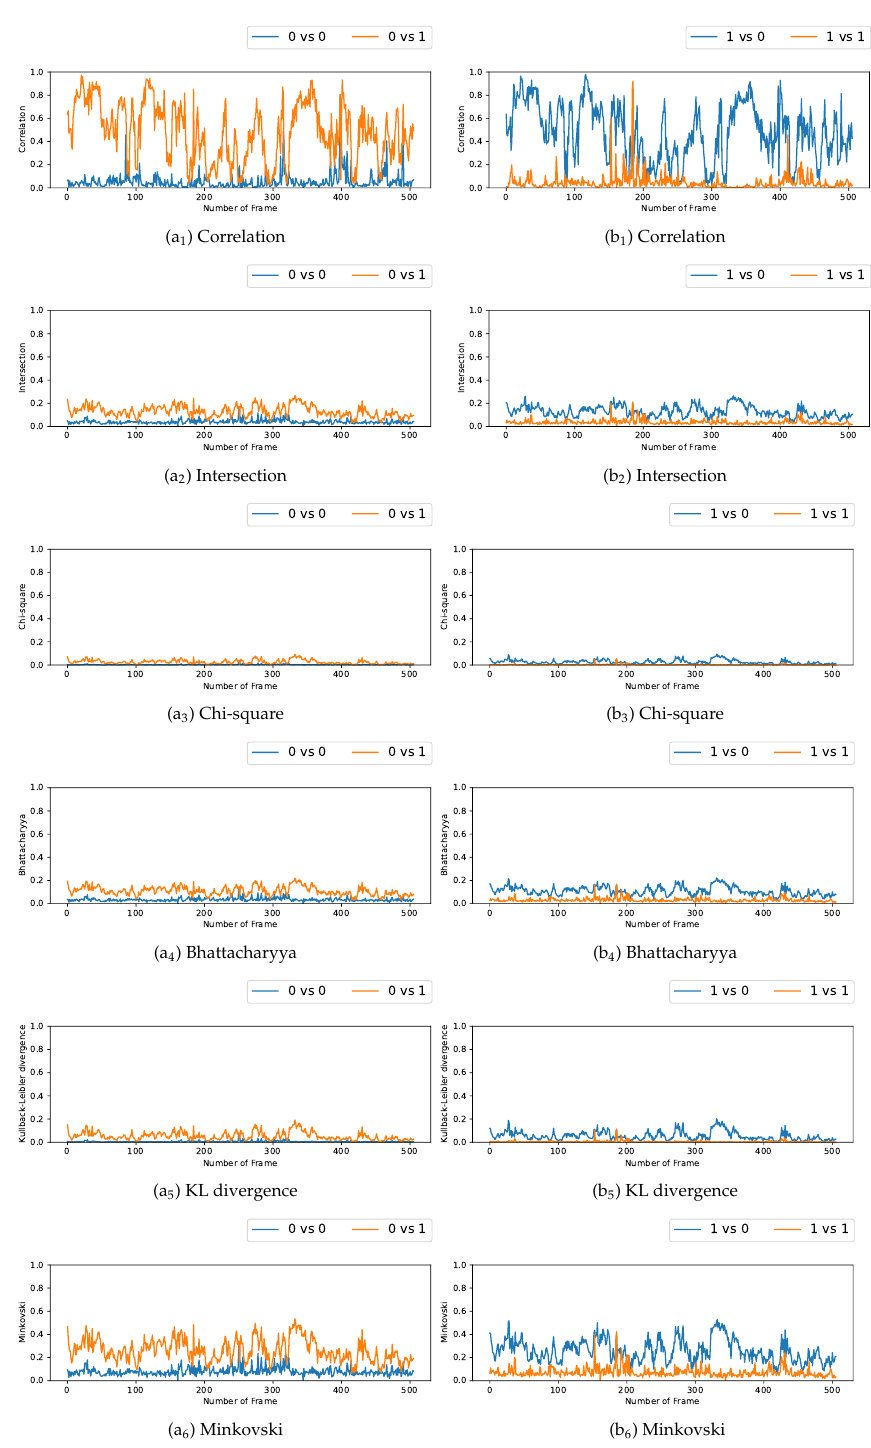
Figure 10. Curves comparing persons from one frame to another in video 3 (persons 0 and 1) using the